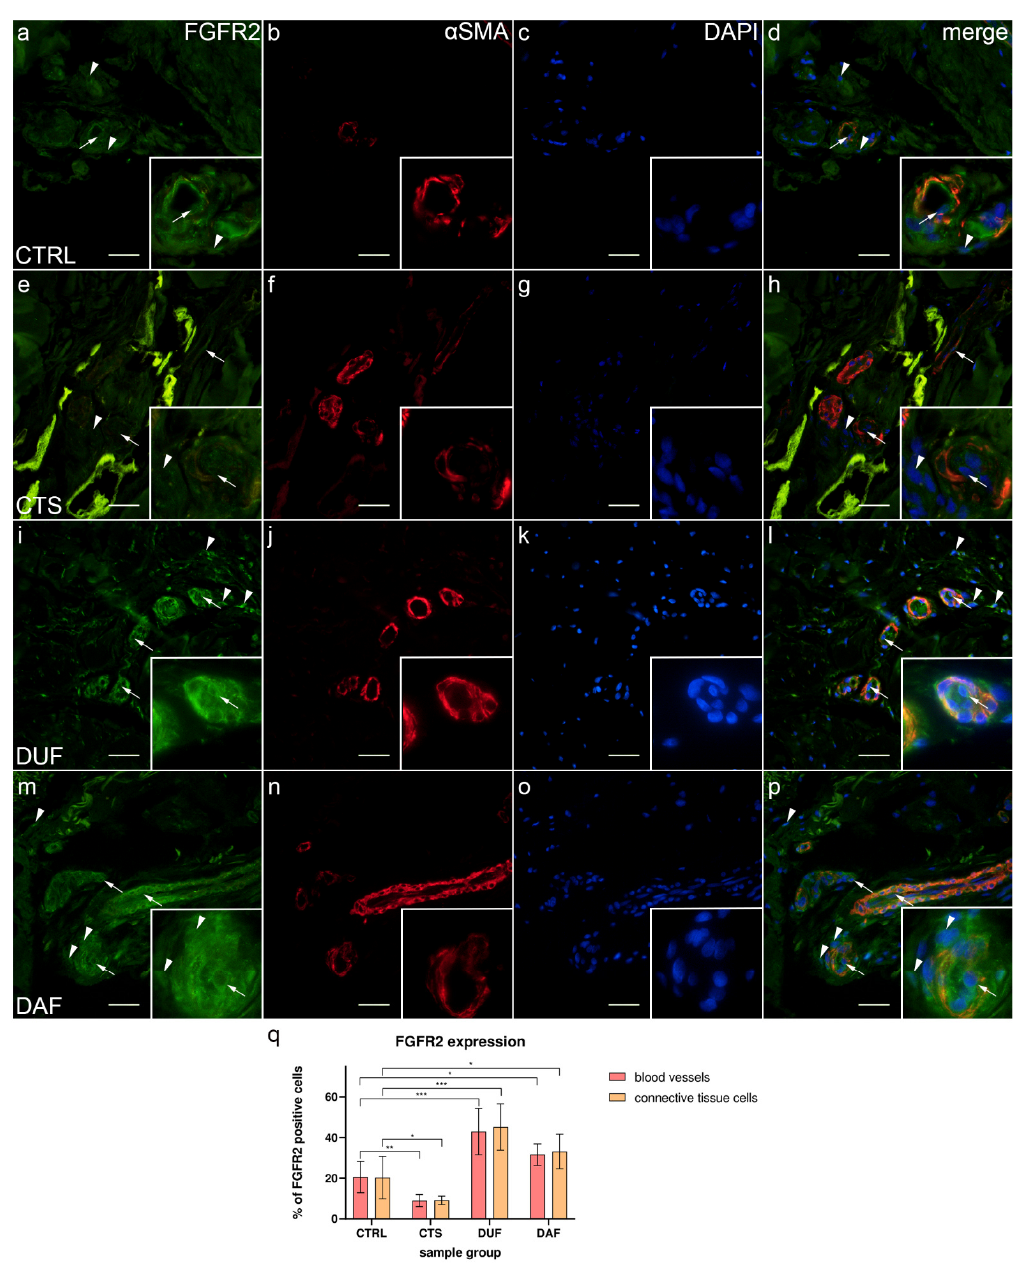
α -SMA staining characterized vascular muscle cells (Figure 6n), while DAPI stained cell nuclei (Figure 6o). The merged image showed CTGF/ α -SMA co-expression the vascular Biomedicines 2022 , 10 , 3214 smooth muscle cells (Figure 6p).